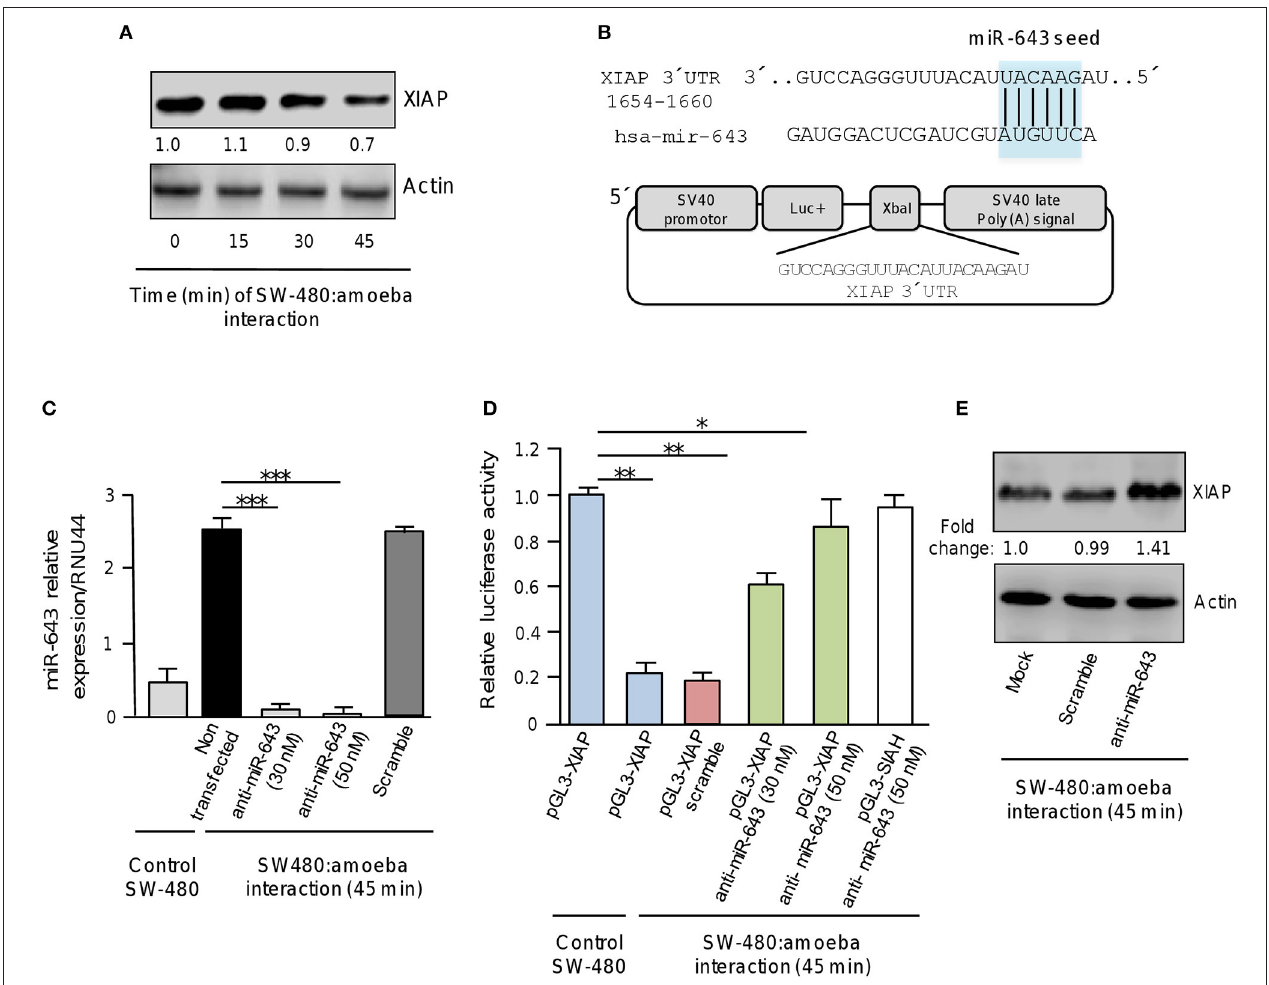
FIGURE 4 | XIAP 3 ′ UTR is a target of miR-643. (A) Western blot assays for XIAP expression. SW-480 cells were incubated with trophozoites for 0, 15, 30, and 45min. Total protein were extracted and XIAP expression was determined by Western blot assays using XIAP antibody (Cell signaling). Actin antibodies (Santa Cruz) were used as control. Numbers represents the fold change in XIAP expression quantified by densitometry and normalized against actin. Values are expressed relative to the control group (time 0h). (B) Schematic representation of pGL3-XIAP construct containing the 3 ′ UTR of XIAP gene cloned at the Xba I site downstream of firefly luciferase gene (Luc + ) of pGL3 Luciferase Reporter Vector. The miR-643 seed sequence is indicated in the colored box. (C) qRT-PCR assays for expression analysis of miR643. SW-480 cells were incubated with trophozoites for 45min and transfected with miR-643 inhibitor at 30nM and 50nM or with scramble sequence (50nM). (D) Luciferase reporter gene assays. SW-480 cells transfected with the pGL3-XIAP were incubated with trophozoites for 45min and co-transfected with anti-miR-643 (30 and 50nm) or scramble (50nM). Luciferase activity was measured after 24h. SW-480 cells transfected with pGL3-XIAP but not exposed to parasites were used as control. (E) Western blot assays showing cropped images for XIAP expression. SW-480 cells transfected with anti-miR-643, scramble or not transfected were incubated with trophozoites for 45min and then submitted to immunoblotting with XIAP and actin antibodies. Bands intensity was quantified by densitometry and normalized to actin. In all cases, data are representative of three independent experiments by duplicate. Error bars represent S.D. The unpaired Student t -test was used to compare each condition with control cells that were not exposed to E. histolytica . * p < 0.05; ** p < 0.01; *** p <